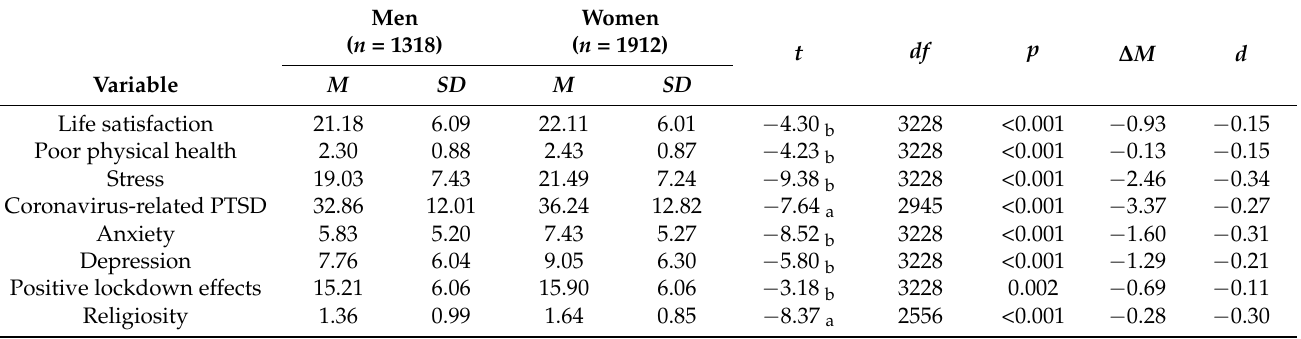
Table 4. Gender differences in mental and physical